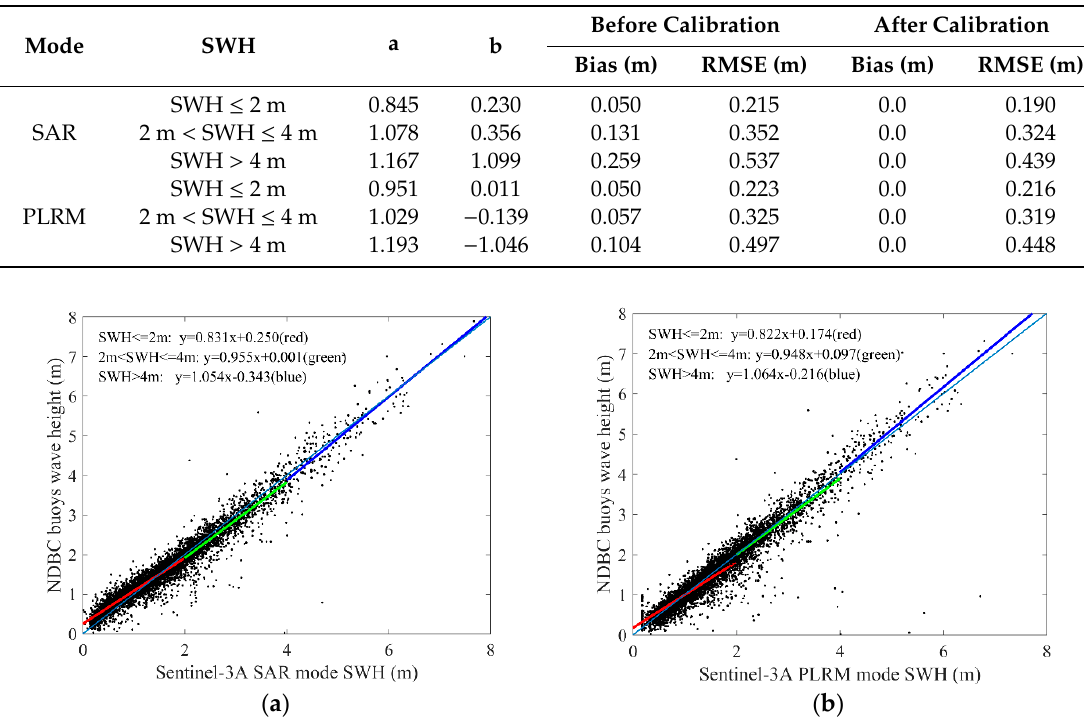
Figure 18. Calibration results of Sentinel-3A SAR ( a ) and PLRM ( b ) mode SWH data.